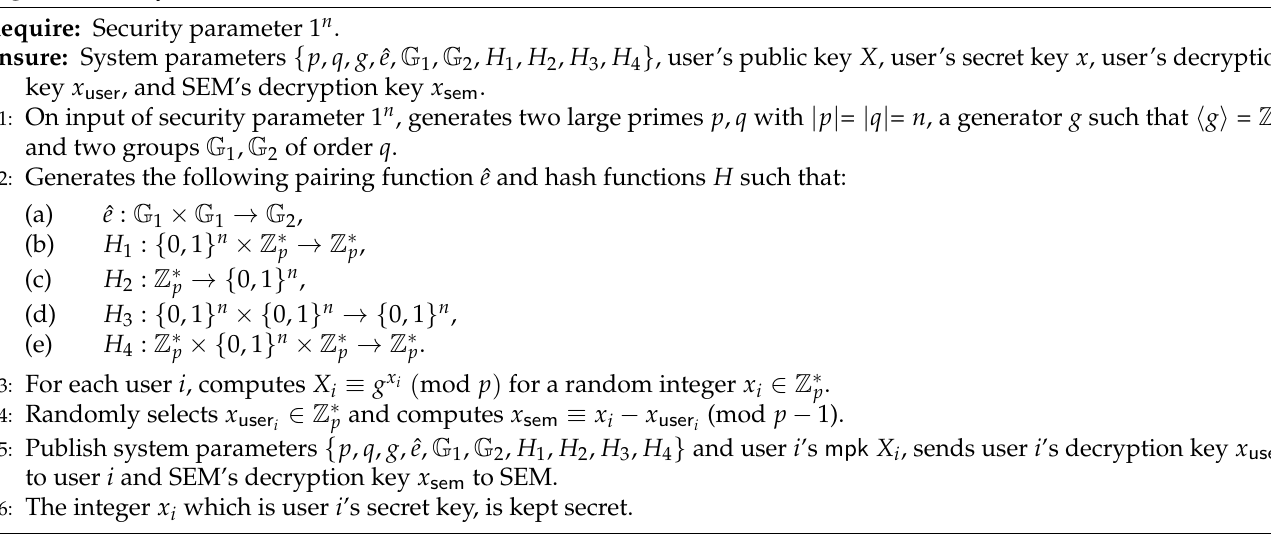
Algorithm 1 Key Generation ( K EY G EN ) of mEG